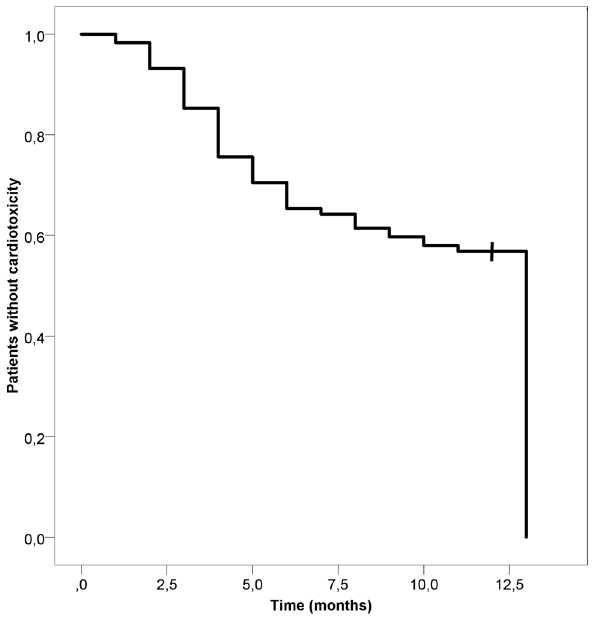
Figure 1. Time to develop cardiotoxicity (censored at 12